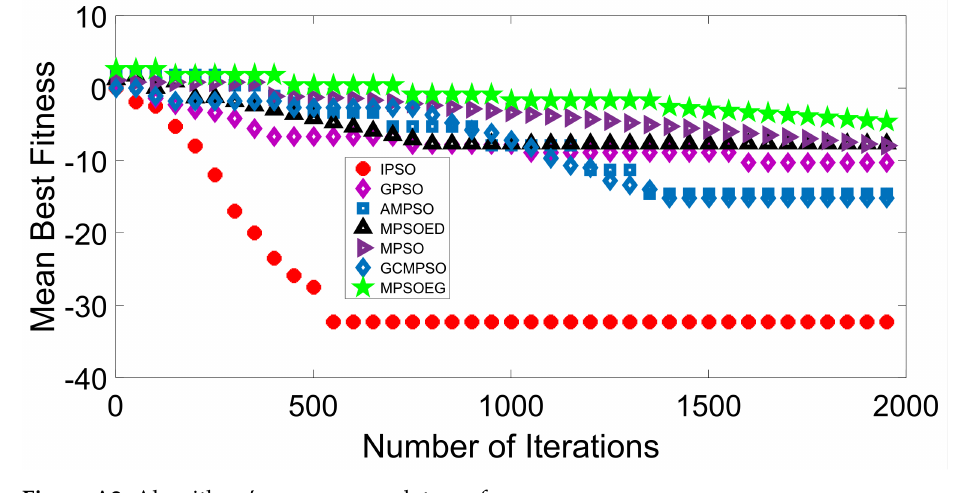
Figure A2. Algorithms’ convergence plots on f 3 .